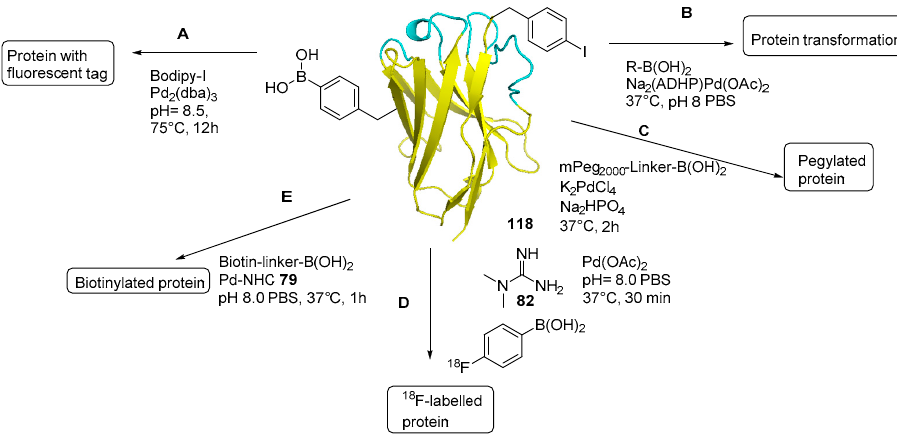
Figure 17. Schematic representation of different strategies for Suzuki–Miyaura reaction on protein substrates. Various proteins were utilized. Here, a common “dummy” substrate 118 is shown for illustrative purposes. (PBS = phosphate buffer).